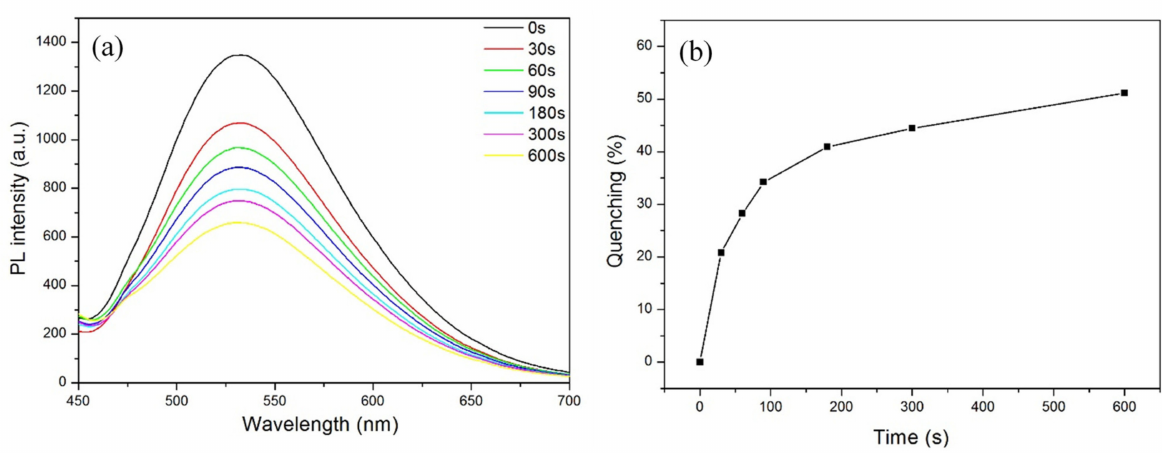
Figure 5. ( a ) Time-dependent PL intensity of n-TPE-AP-PDMS film in NB vapor; ( b ) fluorescence quenching curve in NB at different